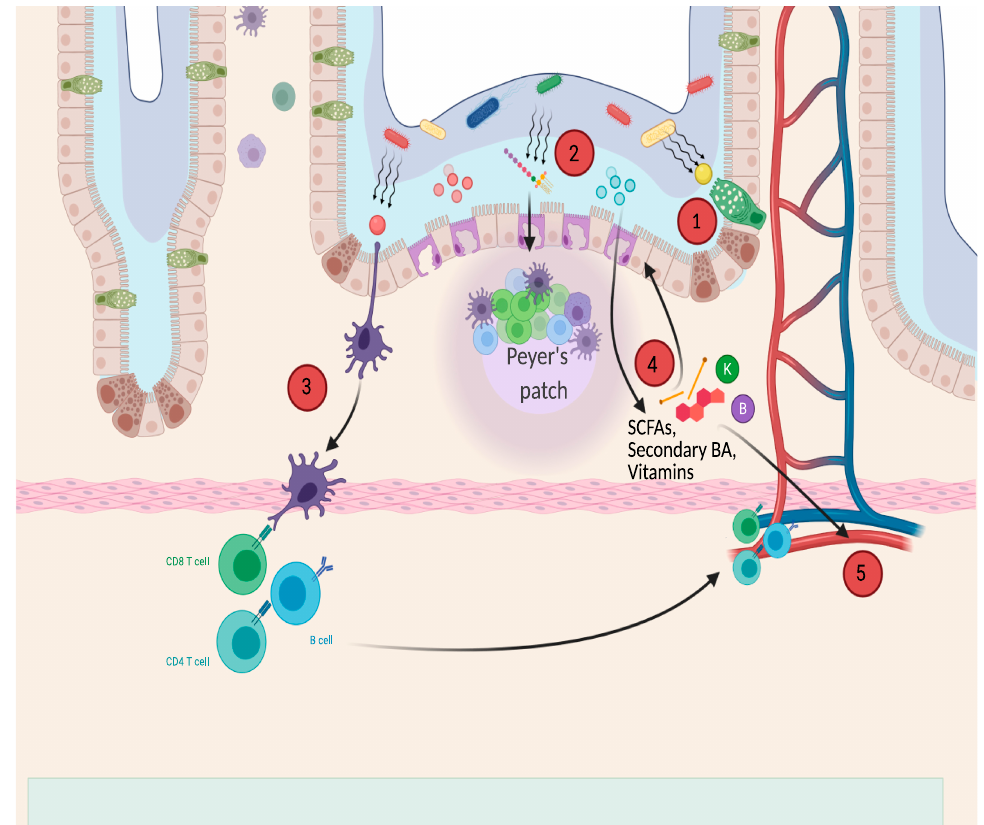
Figure 1. Main hypothesized pathways of postbiotic’s beneficial effects. 1, thickening of the mucus layer; 2-3, antimicrobial effect; 4, local anti-inflammatory effect; 5, systemic effects of postbiotics entering circulation. SCFAs: short-chain fatty acids; BA: biliary acids.